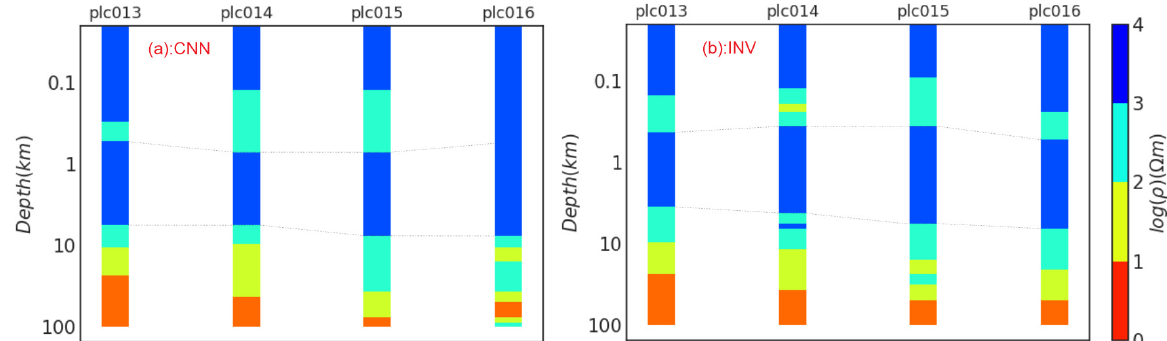
Figure 10. Inline classified resistivity sections of four calculated 1D models with CNN inversion ( a ) and iterative inversion ( b ), which show the correlations of resistivity variations.